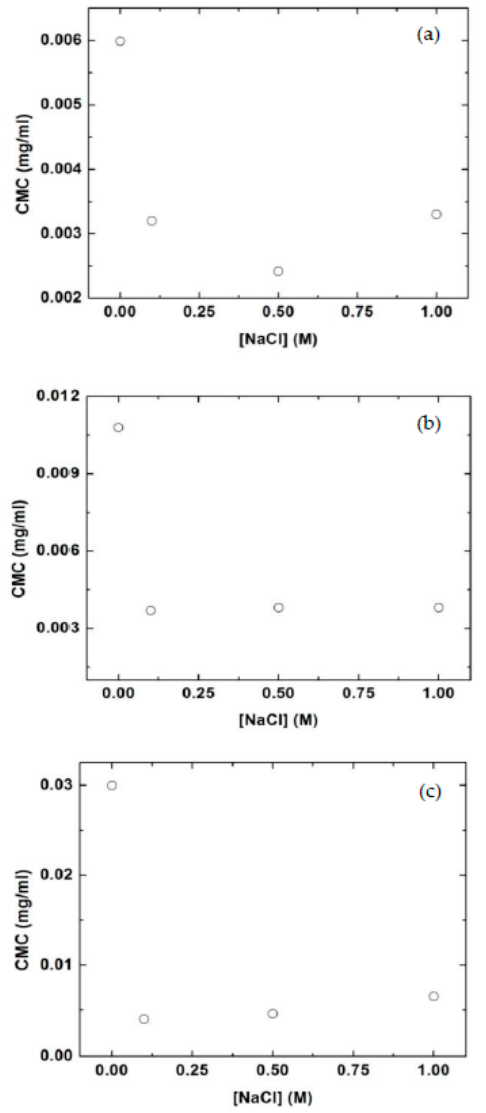
Figure 6. Variation of critical micelle concentration of: ( a ) EHA 22 - b -GLBT 55 ; ( b ) EHA 15 - b -GLBT 117 ; and ( c ) EHA 20 - b -GLBT 156 as a function of sodium chloride solutions.